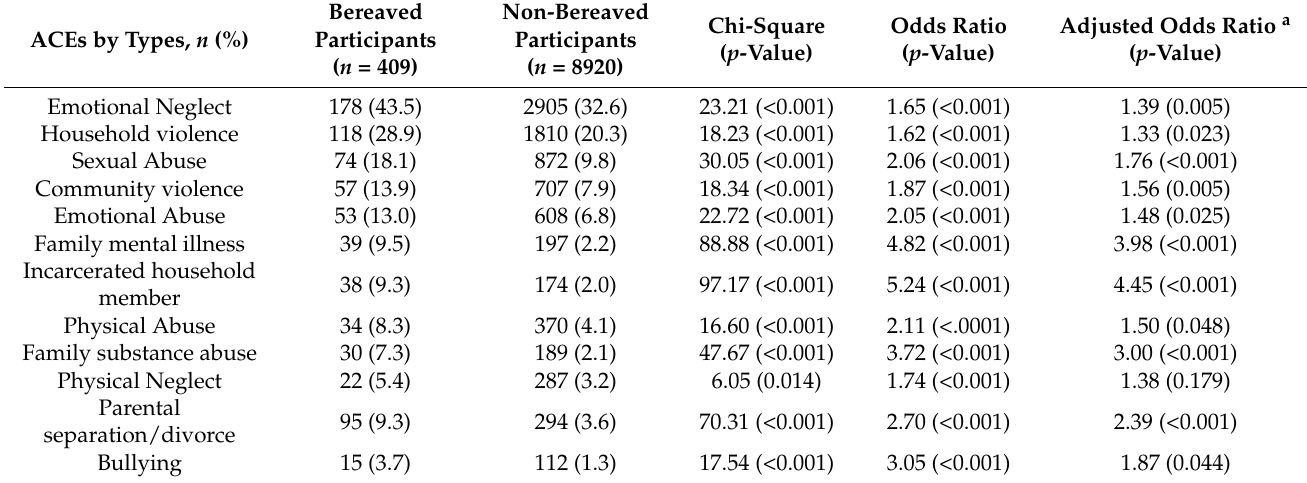
Table 2. ACEs types of exposure by adult self-reported childhood bereavement